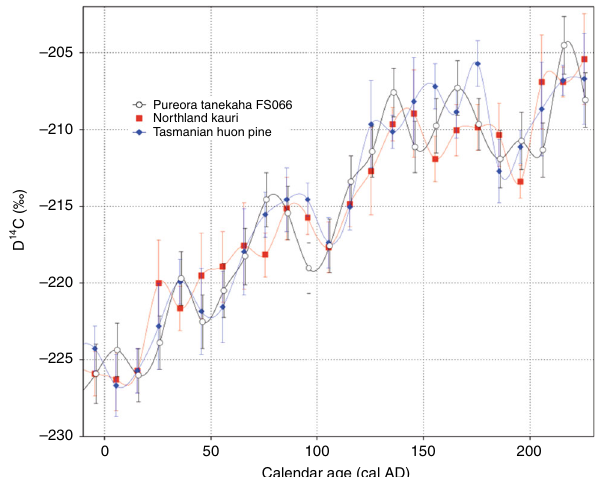
Fig. 1 Comparisons of radiocarbon concentrations from New Zealand and Tasmania trees. Radiocarbon concentration (D 14 C, 1 σ error bars) plotted against calendar age for the Pureora tanekaha tree FS066 4 together with Northland kauri 14 and Tasmanian huon pine 15 . It should be noted that the vertical axis title in HDK18 ’ s Fig. 3 is incorrect — it should read D 14 C, as above, not Δ 14 C, which is age-corrected 14 C concentration